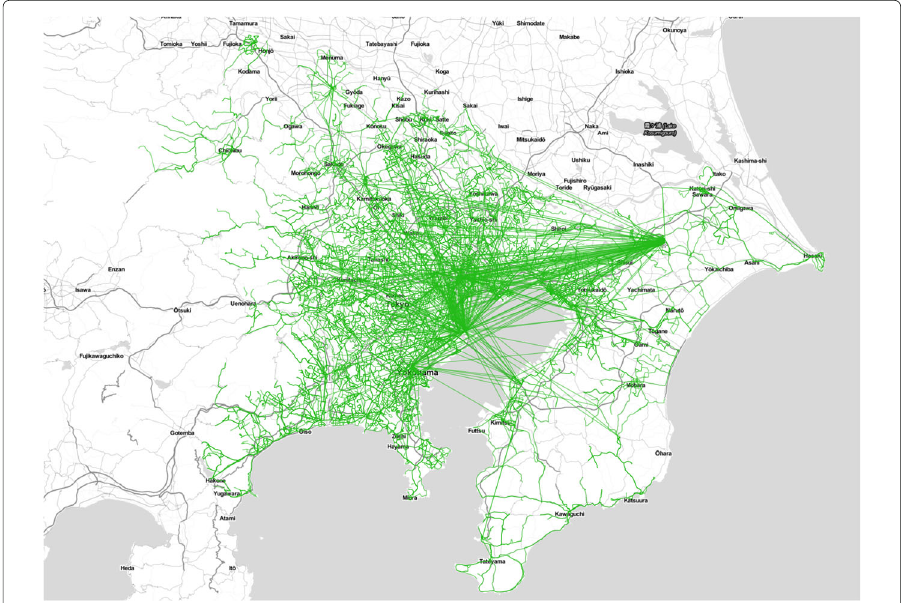
Fig. 5 A map of the Tokyo area showing the edges of the bus network. Map tiles by Stamen Design(Stamen Design 2019), map data by OpenStreetMap(OpenStreetMap Contributors